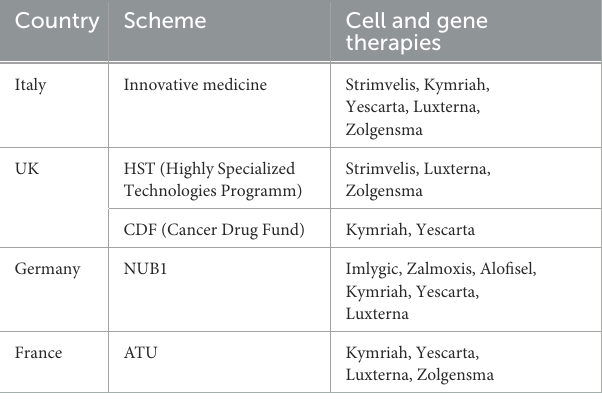
TABLE 7 Schemes to improve the accessibility of cell and gene therapies across EU countries. Country Scheme Cell and gene